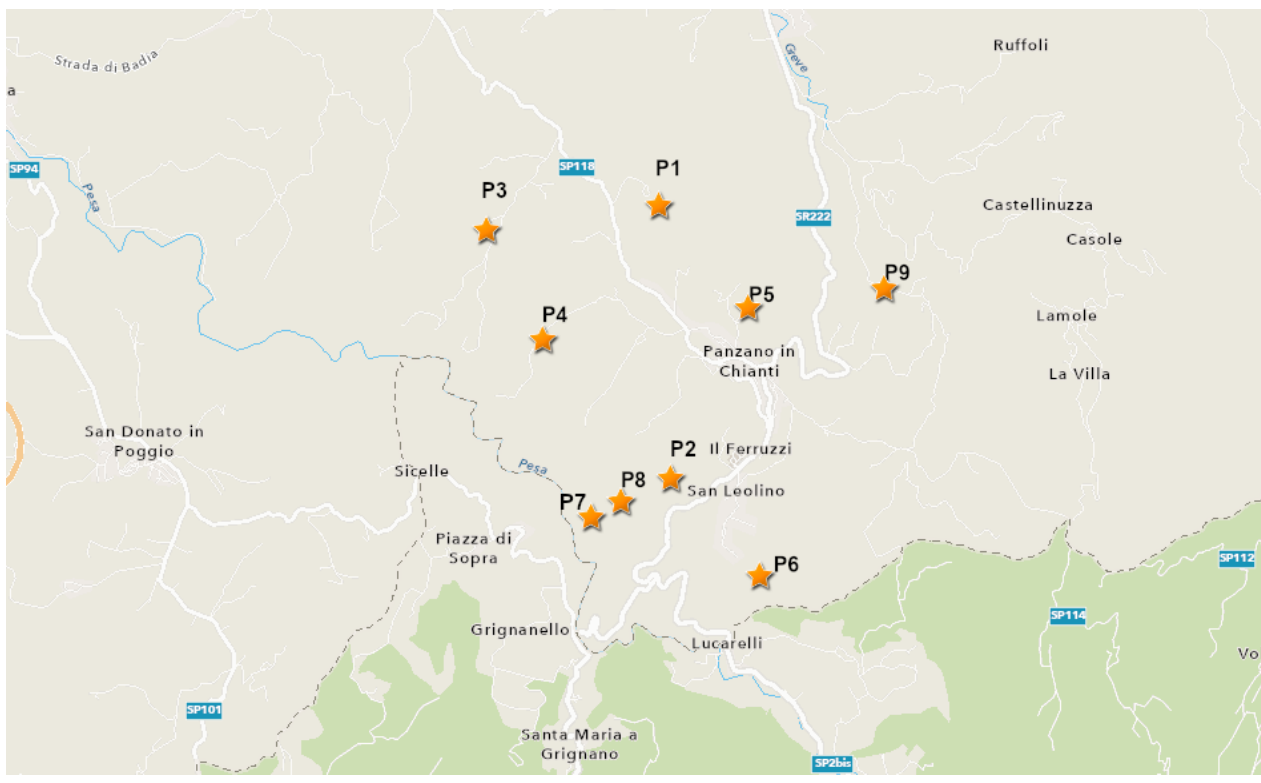
Figure 12. Map of the province of Panzano in Chianti (FI), where the locations of the vineyards (P1–P9) are indicated by orange stars. Map made with ArcGIS (https://www.arcgis.com/home/webmap/viewer.html accessed on 20 November 2022).